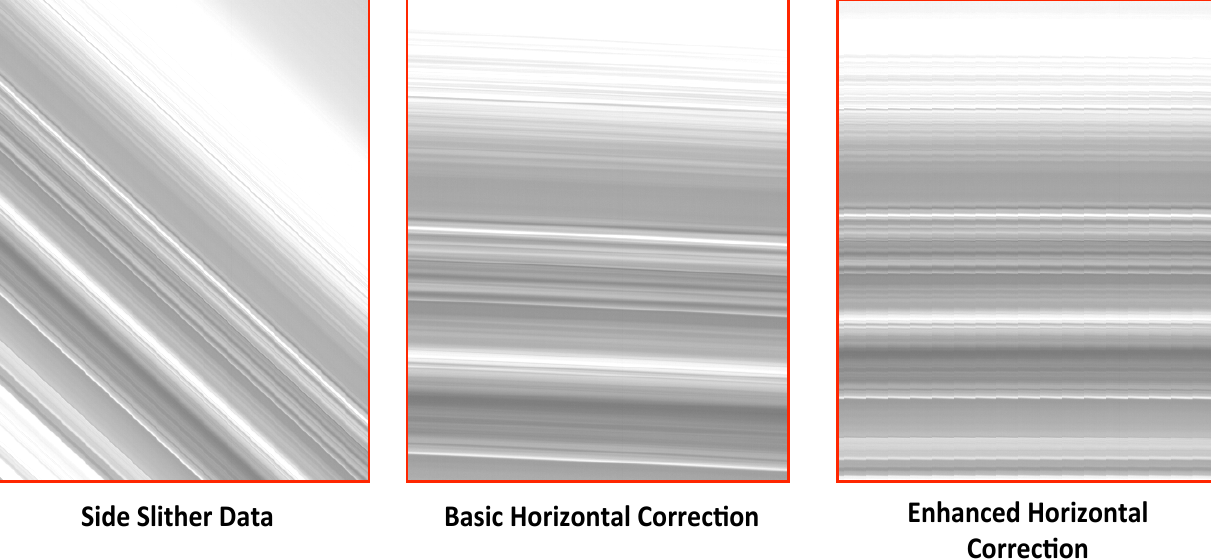
Figure 4. Illustration of the horizontal correction process where raw Thermal Infrared Sensor (TIRS) side slither data ( left ) was corrected using a nominal correction ( center ) and an enhanced correction ( right